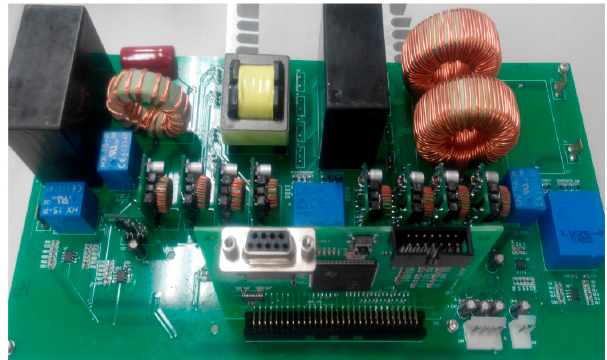
Figure 11. Experimental setup to assess proposed micro-inverter.